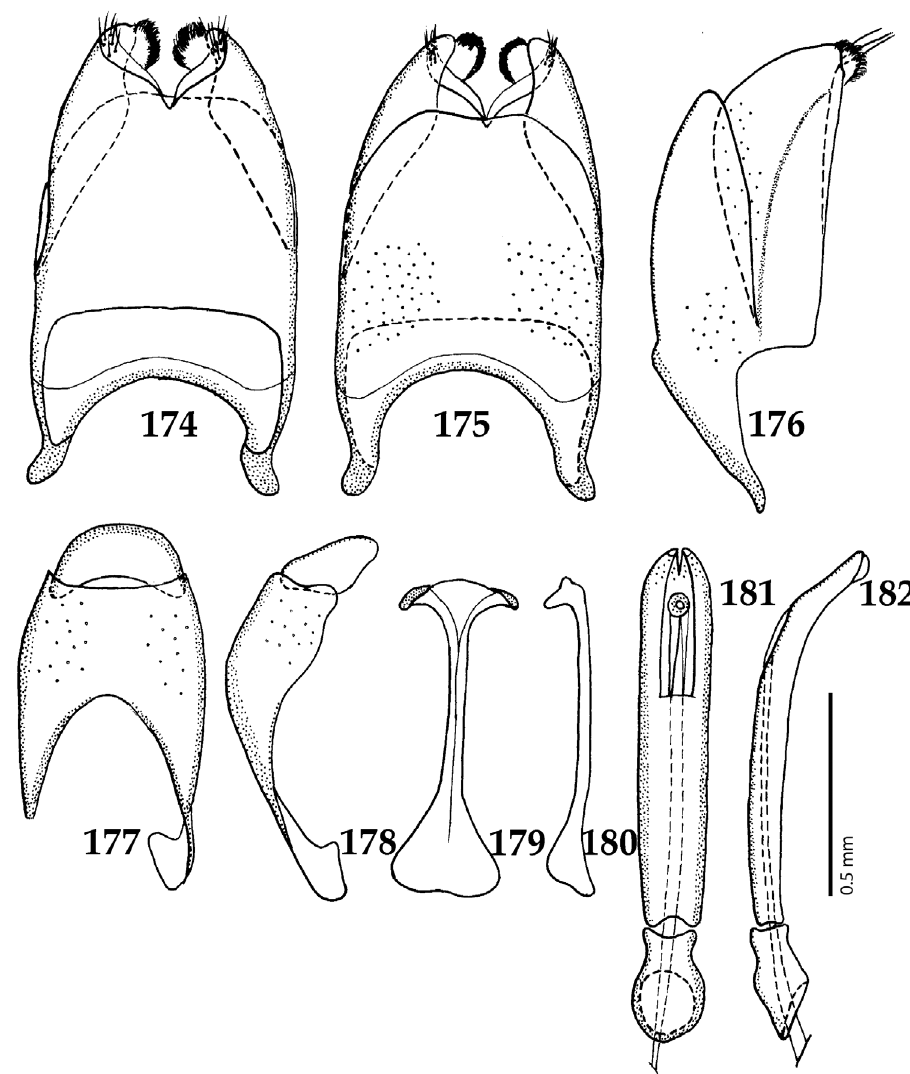
Figures 174–182. 174 Hypocaccus ( Hypocaccus ) sinae (Marseul, 1862) male terminalia: 8 th sternite + 8 th tergite, ventral view 175 ditto, dorsal view 176 ditto, lateral view 177 male terminalia: 9 th + 10 th tergites, dorsal view 178 ditto, lateral view 179 male terminalia: spiculum gastrale, ventral view 180 ditto, lateral view 181 male terminalia: aedeagus, dorsal view 182 ditto, lateral